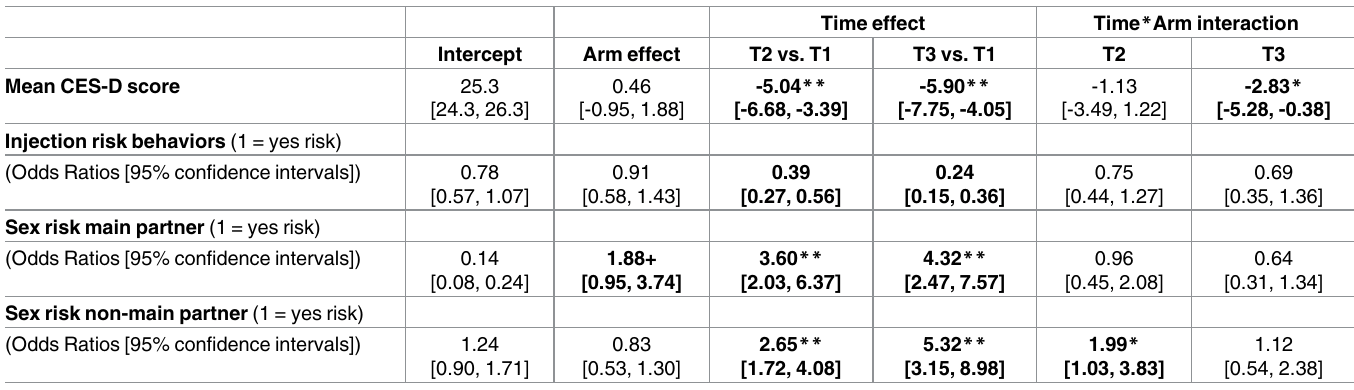
Table 3. GEE model results of intervention arm and time effect (n = 315) of Workshop intervention, Baltimore Maryland (n =